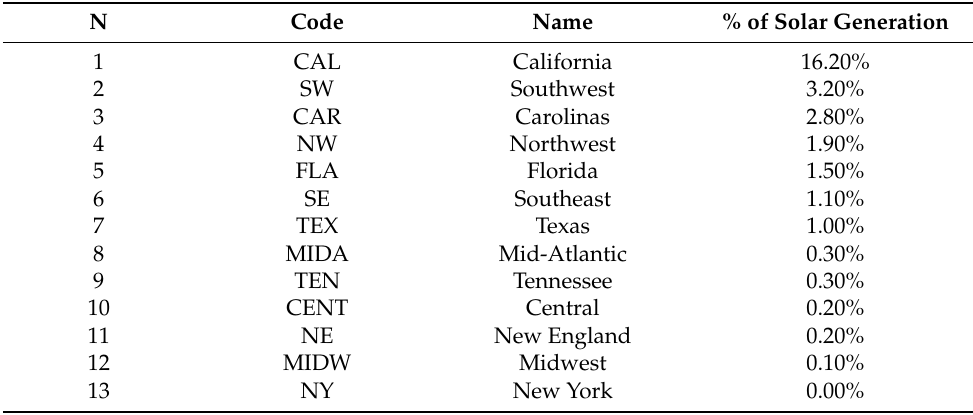
Table 1. List of regions in the US electric power system.